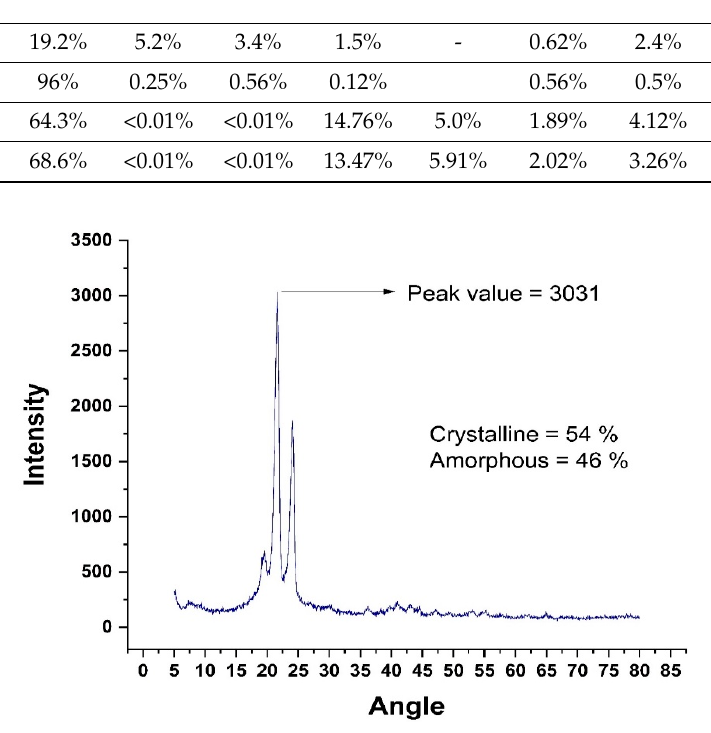
Figure 1. XRD Analysis of Virgin HDPE .